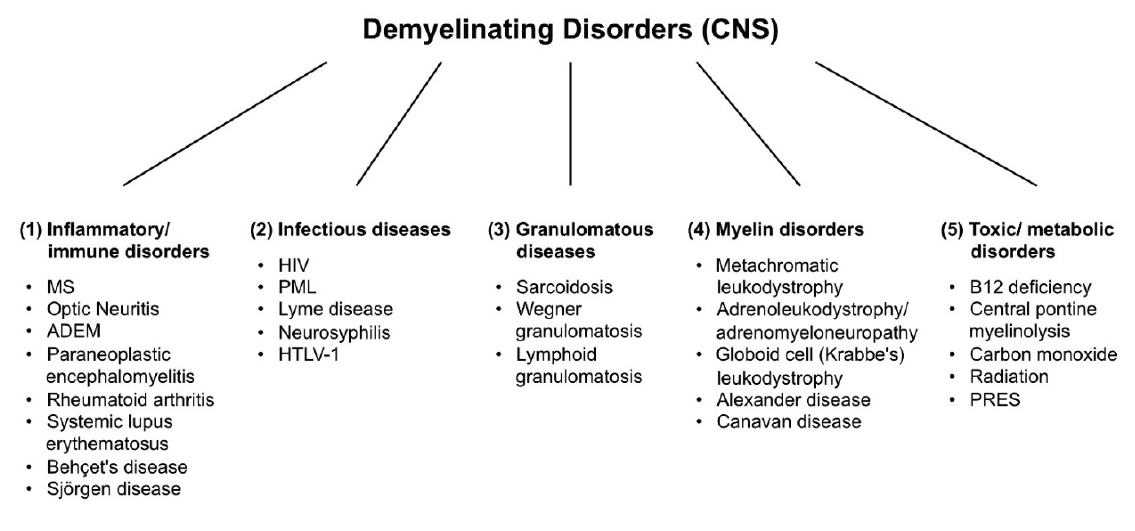
Figure 2. Demyelinating disorders of the central nervous system (CNS). Abbreviations: MS: multiple sclerosis; ADEM: acute disseminated encephalomyelitis; HIV: human immunodeficiency virus; PML: progressive multifocal leukoencephalopathy; HTLV-1: human T-lymphotropic virus 1; PRES: posterior reversible encephalopathy